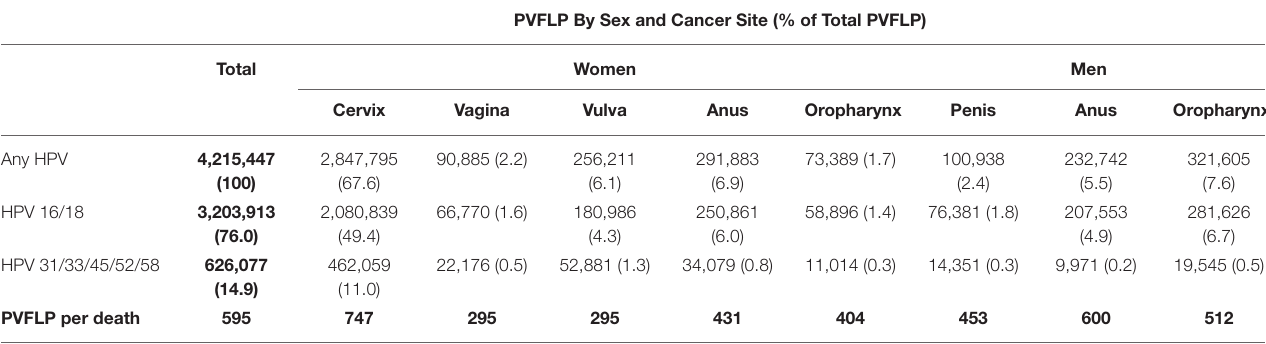
TABLE 4 | Estimated present value of future lifetime productivity due to HPV-attributable cancer deaths by sex and HPV type (in thousands, 2017